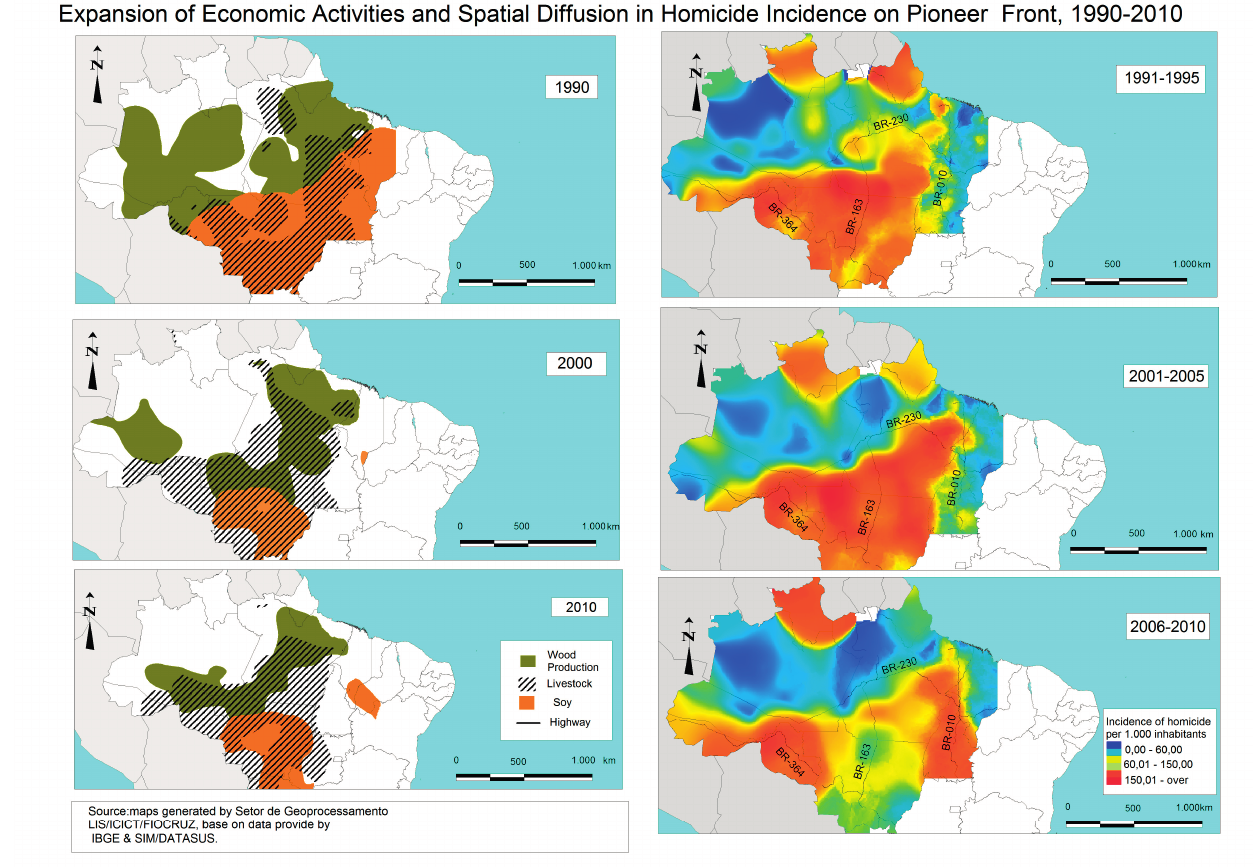
Figure 1. Maps of homicide rates in the Legal Amazon by period. * The average rate of homicides values corresponds: Low 0–60 (per 100 thousand inhabitants); Medium 60–150 (per 100 thousand inhabitants); High < 150 (per 100 thousand